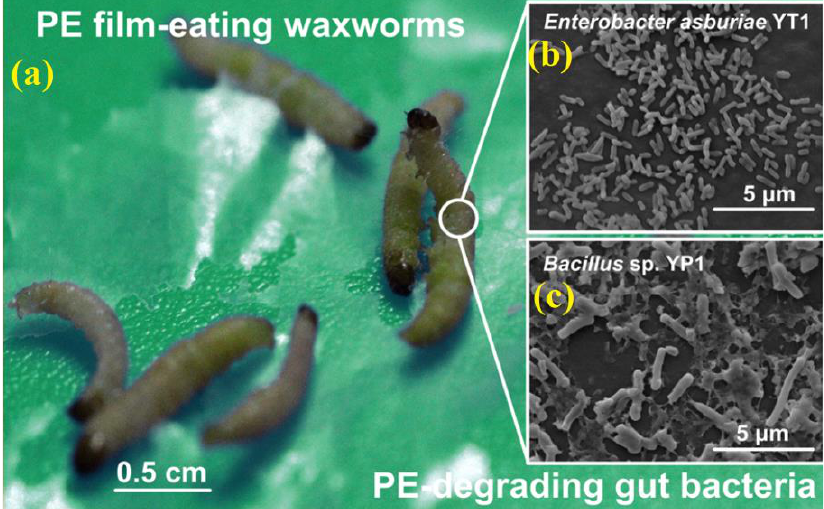
Figure 9. ( a ) PE film-eating waxworms. ( b , c ) Morphotypes of the cells in the mature biofilm on the PE sheet, reprinted with permission from [43].